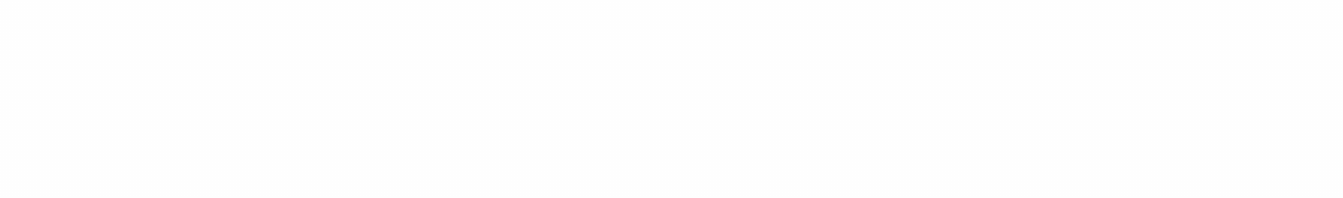
FIGURE 2 Different interval length histograms: (a) single smooth peak, (b) single narrow peak superimposed on a smooth background, (c) multiple peaks.